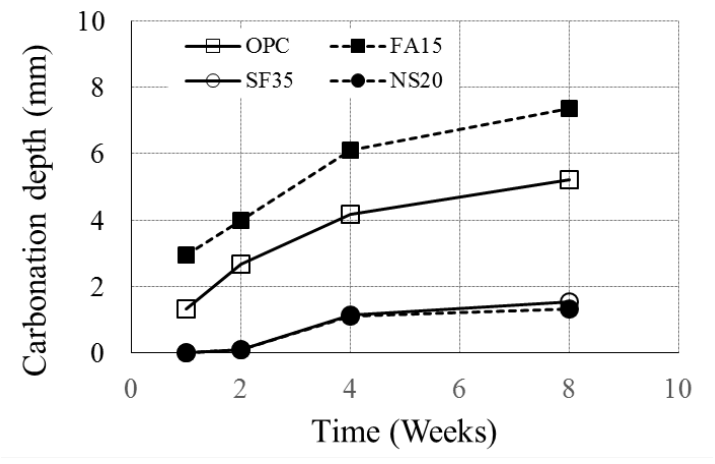
Figure 9. Carbonation depth evolution.